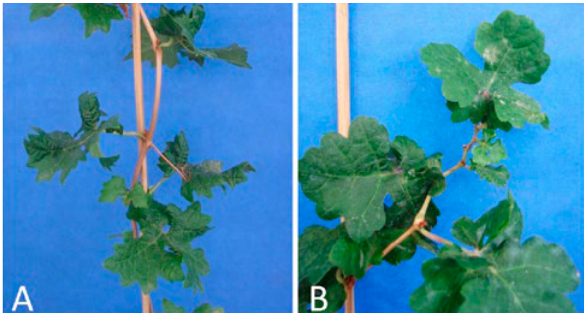
Figure 5. Symptoms associated with phytoplasma presence in grapevine after Bergallia valdiviana transmission. Short internodes, and leaves with downward rolling and deformation: A) VC85A; B) V86C.